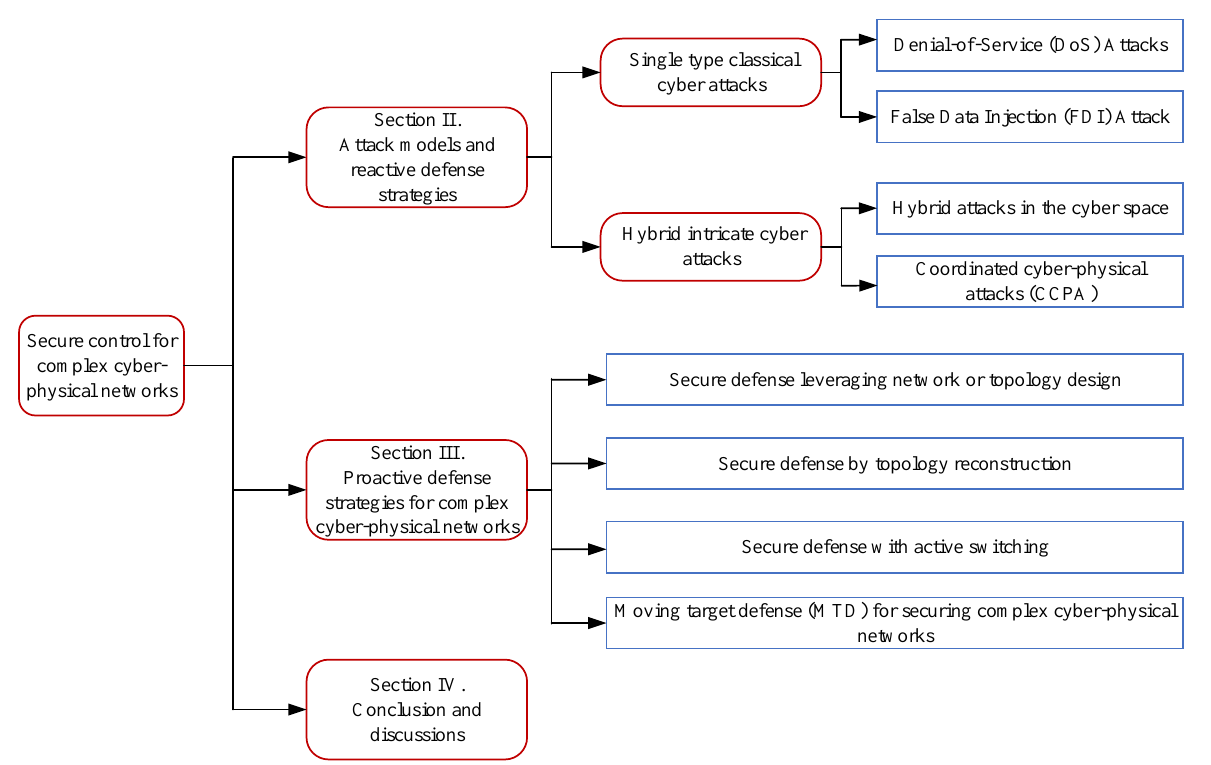
Figure 2. The main structure of this